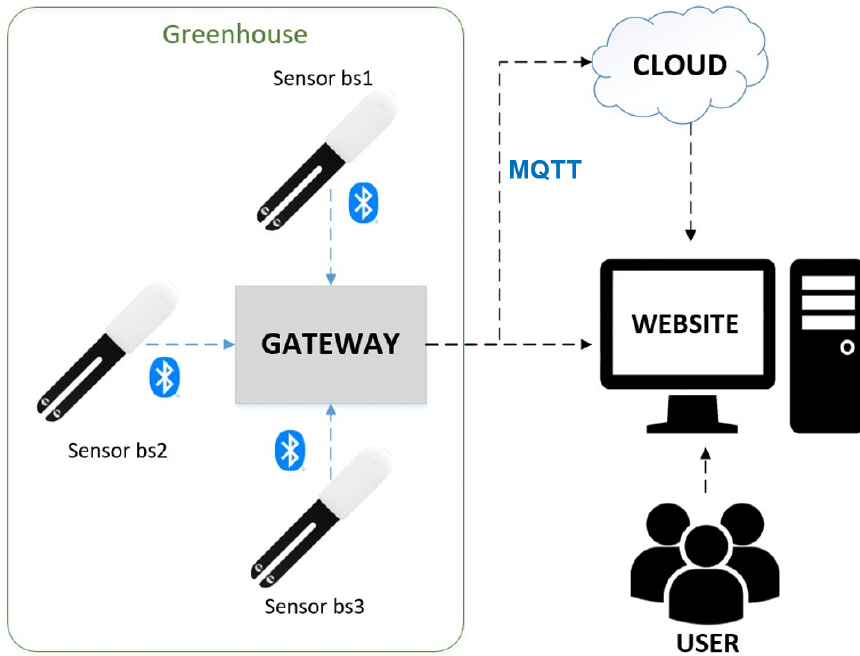
Figure 2. Greenhouse environment monitoring system structure.